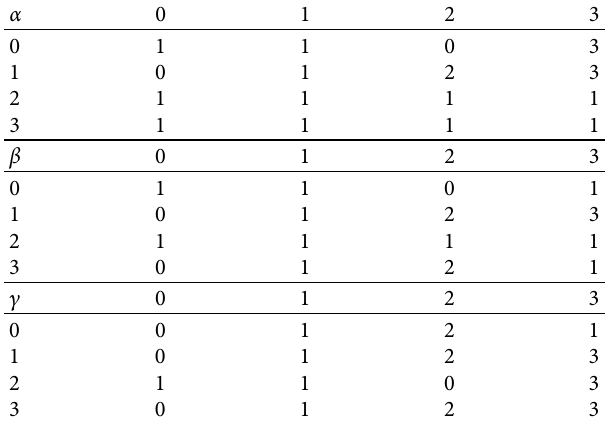
Table 1: Cayley tables for the binary operations “ α , β , and c